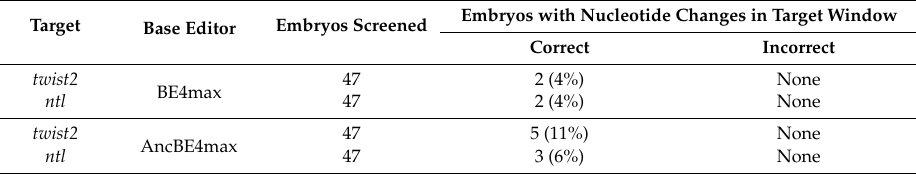
Table 2. Details of screening for somatic base